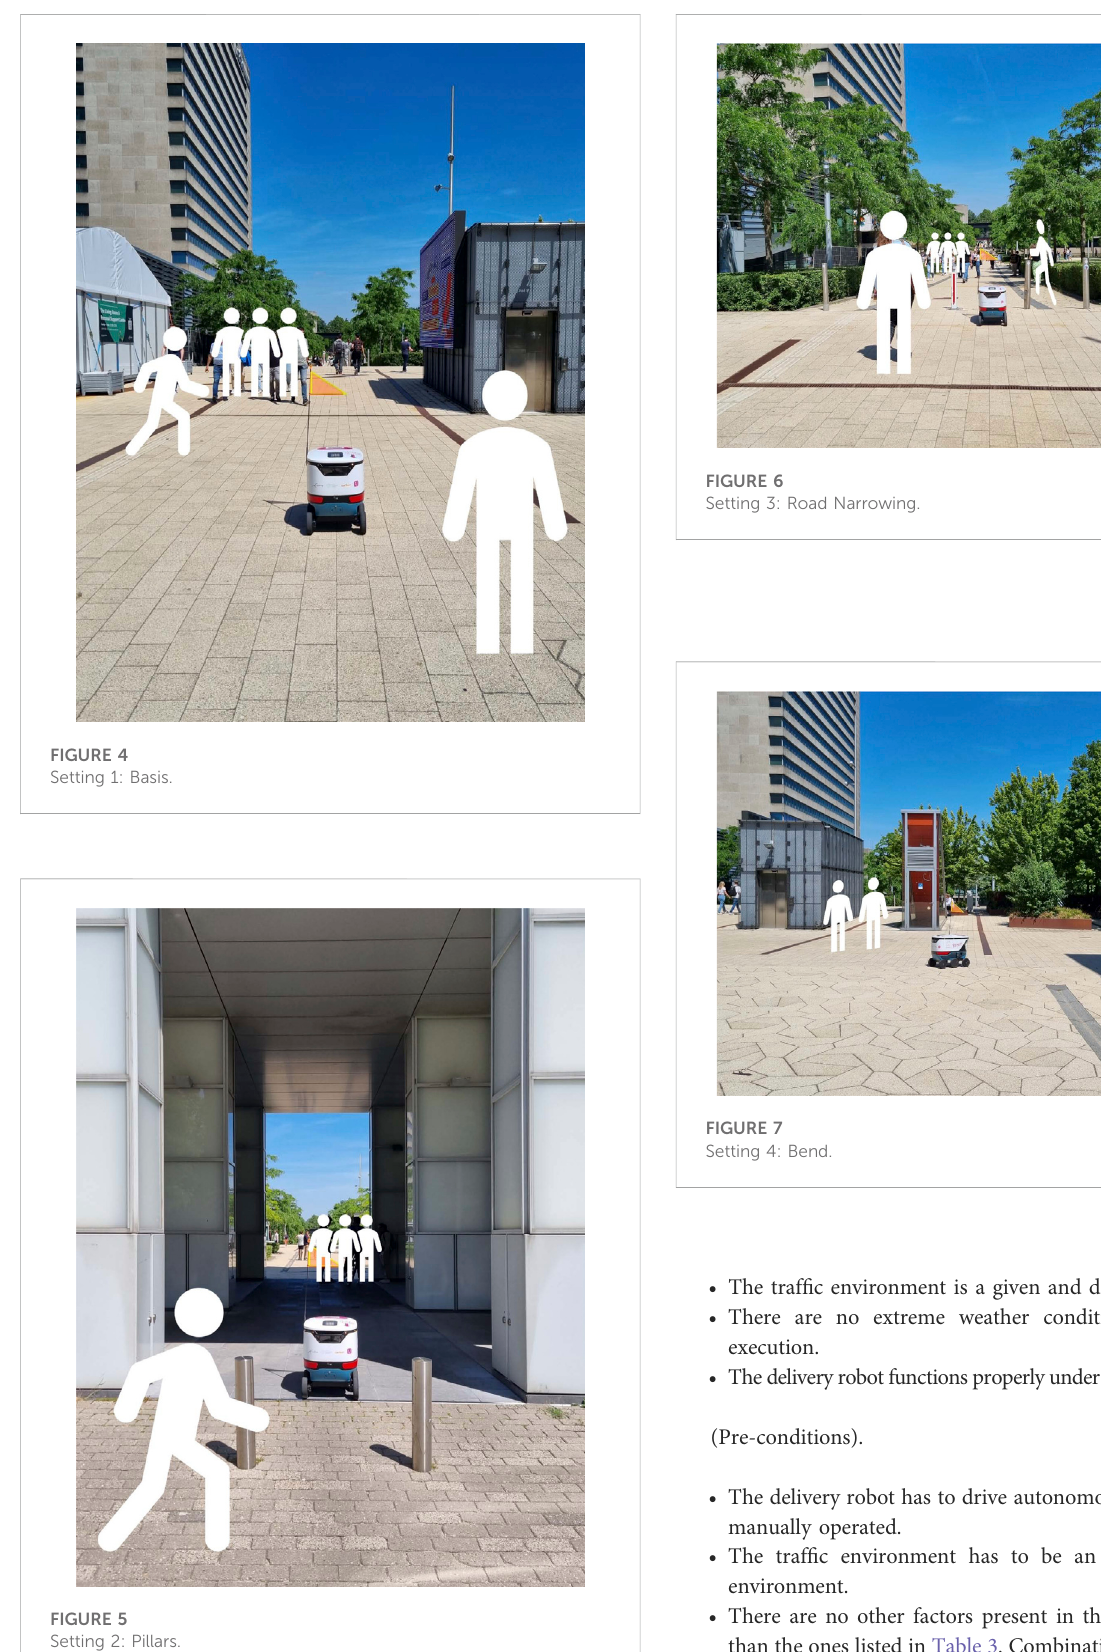
FIGURE 5 Setting 2: Pillars.